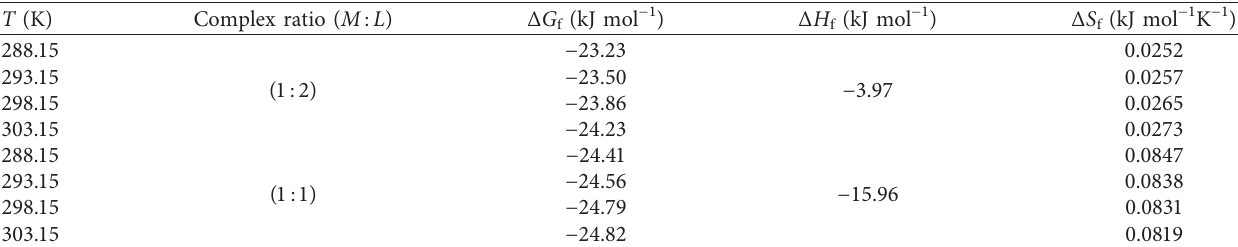
f ), enthalpy change ( Δ H f ), and entropy change ( Δ S f )) for